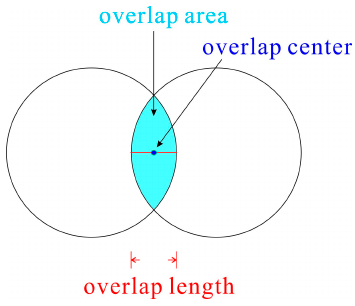
Figure 12. Definitions of the overlap area, overlap center, and overlap length.